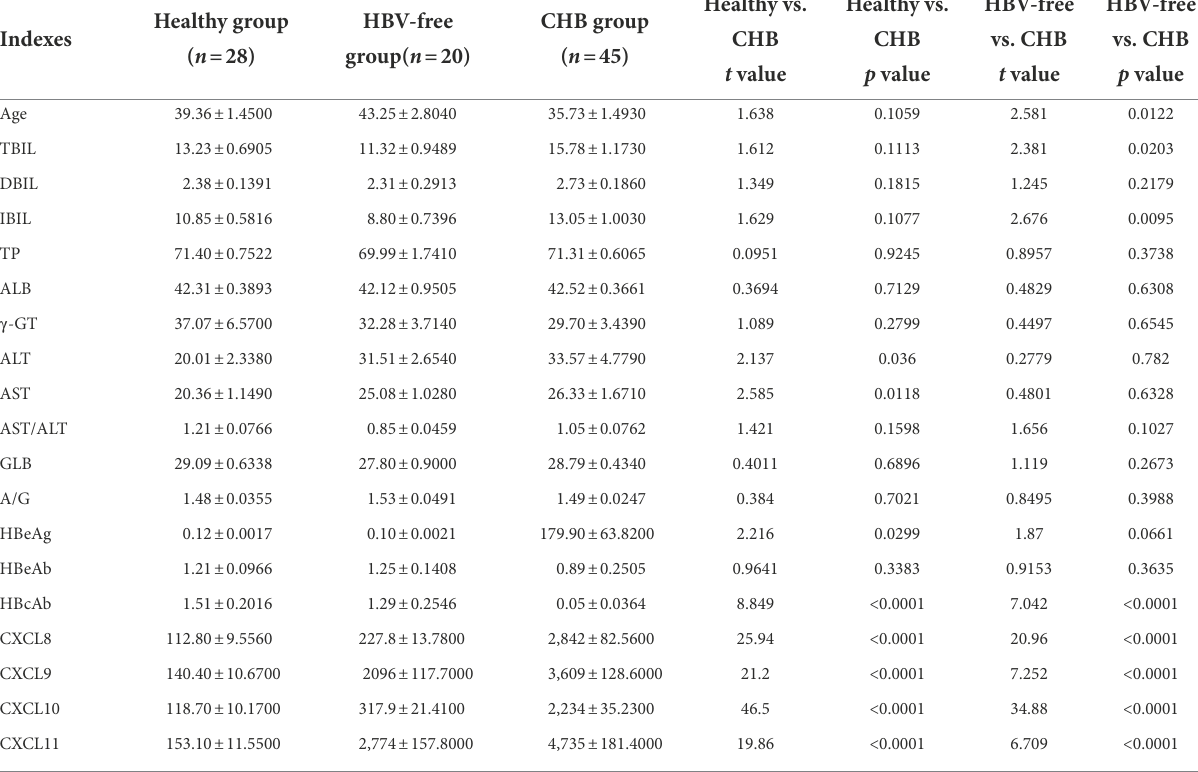
TABLE 2 Comparison of differences between the Healthy group, the HBV-free group and the CHB group.